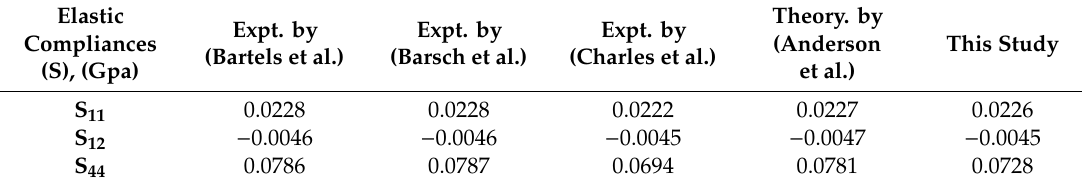
Table 2. Elastic compliance values of NaCl extracted by experimental / theoretical literature and this study.